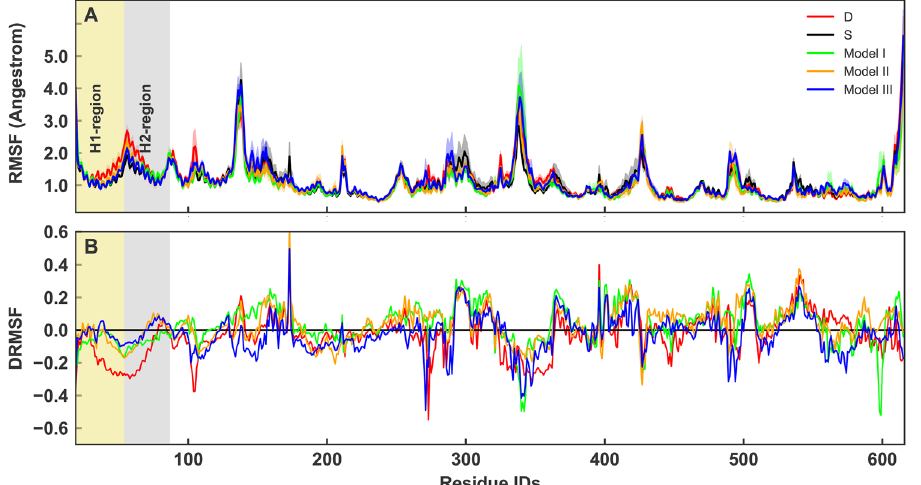
Figure 5. ( A ) RMSF per residue of ACE2 calculated from all replicates of each system and are shown for model S (black), model I (lime), model II (orange) and model III (blue). Light shades around each plot presents standard error for each calculation. RMSF of model D is shown in red. The transparent boxes indicates H1 and H2. ( B ) The relative difference in RMSF, D RMSF is shown per residue for all the models (with the same color codes).